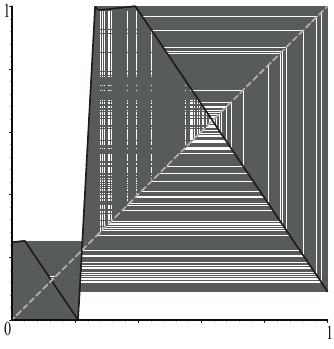
Figure 10. Iterative paths of H 2 ( Ψ ) .